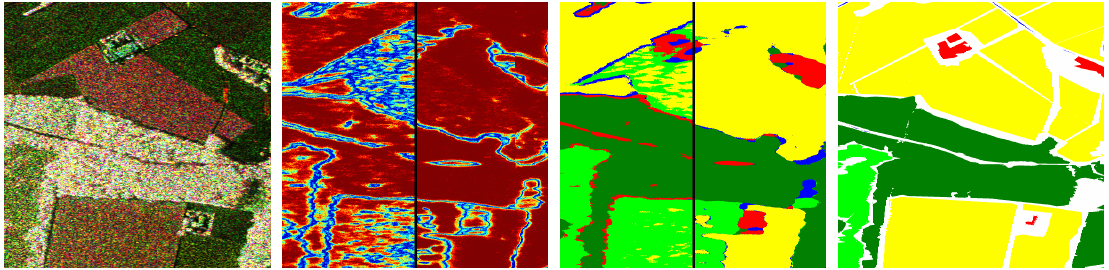
Figure 1. We propose stacking of Random Forests for the pixel-wise classification of PolSAR data, which gradually increases the correctness of the label map as well as the certainty of the classifier in its decisions. From left to right: detail of a PolSAR image; certainty of the RF illustrated as margin of the class posterior of the first (left side) and the last (right side) level; obtained classification maps at the first (left side) and the last (right side) level; reference data (colors denote different classes, see Figure